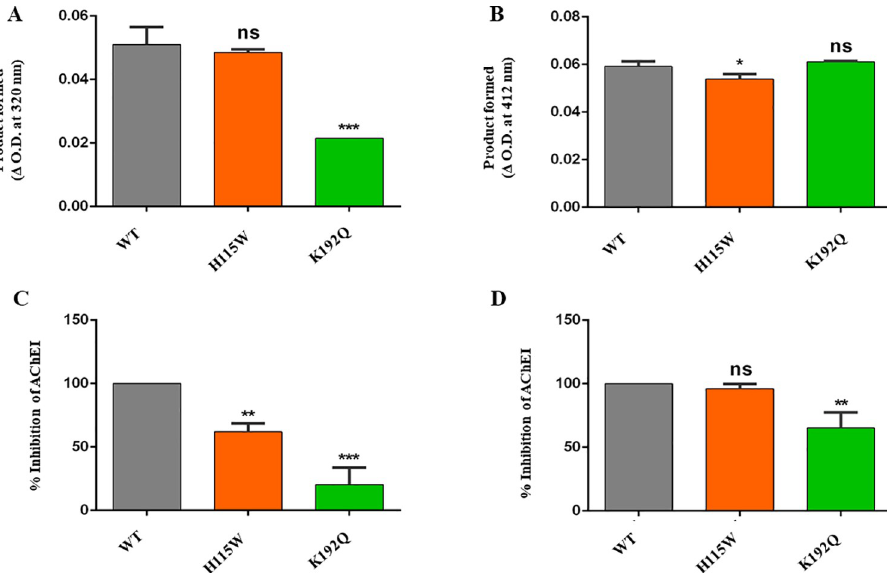
Fig 5. Comparative activities of HuPON2-WT and catalytic site mutants and corresponding inhibition of selected AChEIs. A. Esterase activity of HuPON2-WT compared with catalytic site mutants, B. Lactonase activity of HuPON2-WT compared with catalytic site mutants. The catalytic activity was followed in intervals ranging from 0 to 30 minutes. The activities were reported as product formed in terms of initial and final absorbance measured. Inhibition of AChEI by C. DHC and D. PB respectively in the presence of purified HuPON2-WT and mutant proteins. The well without HuPON2 protein was used as a control. Inhibition was reported as a percentage to control wells read. Results are the average of triplicates and error bars show the standard